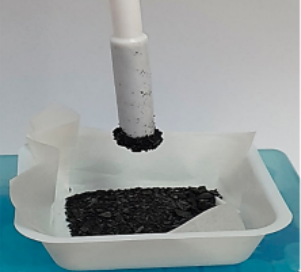
Figure 3. Dry grinded ZVI@ORMOSIL powder on a magnetic